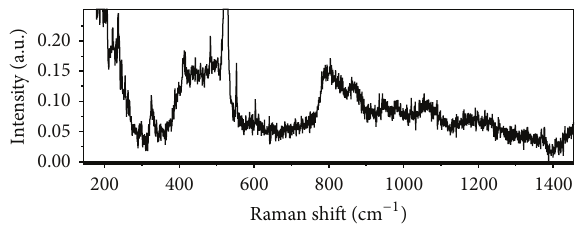
Figure 4: Raman spectrum measured for Si/GdSiO sample, excita- tion wavelength